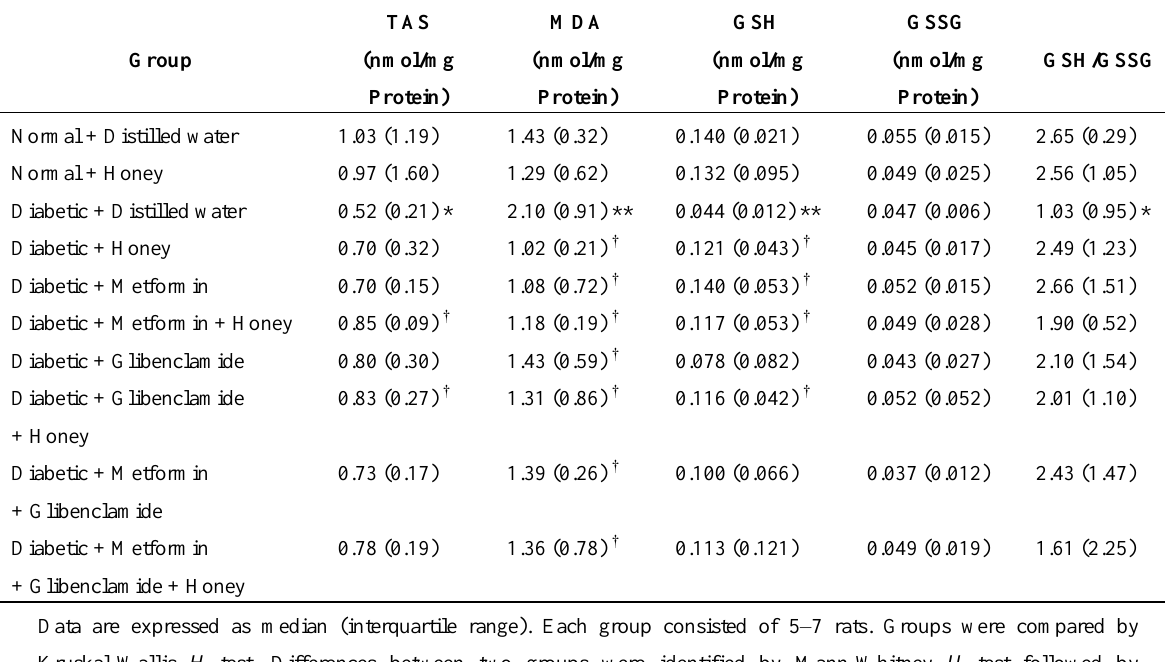
Table 2. Effects of honey, metformin, glibenclamide or their combinations on markers of oxidative stress in the kidneys of control and streptozotocin-induced diabetic